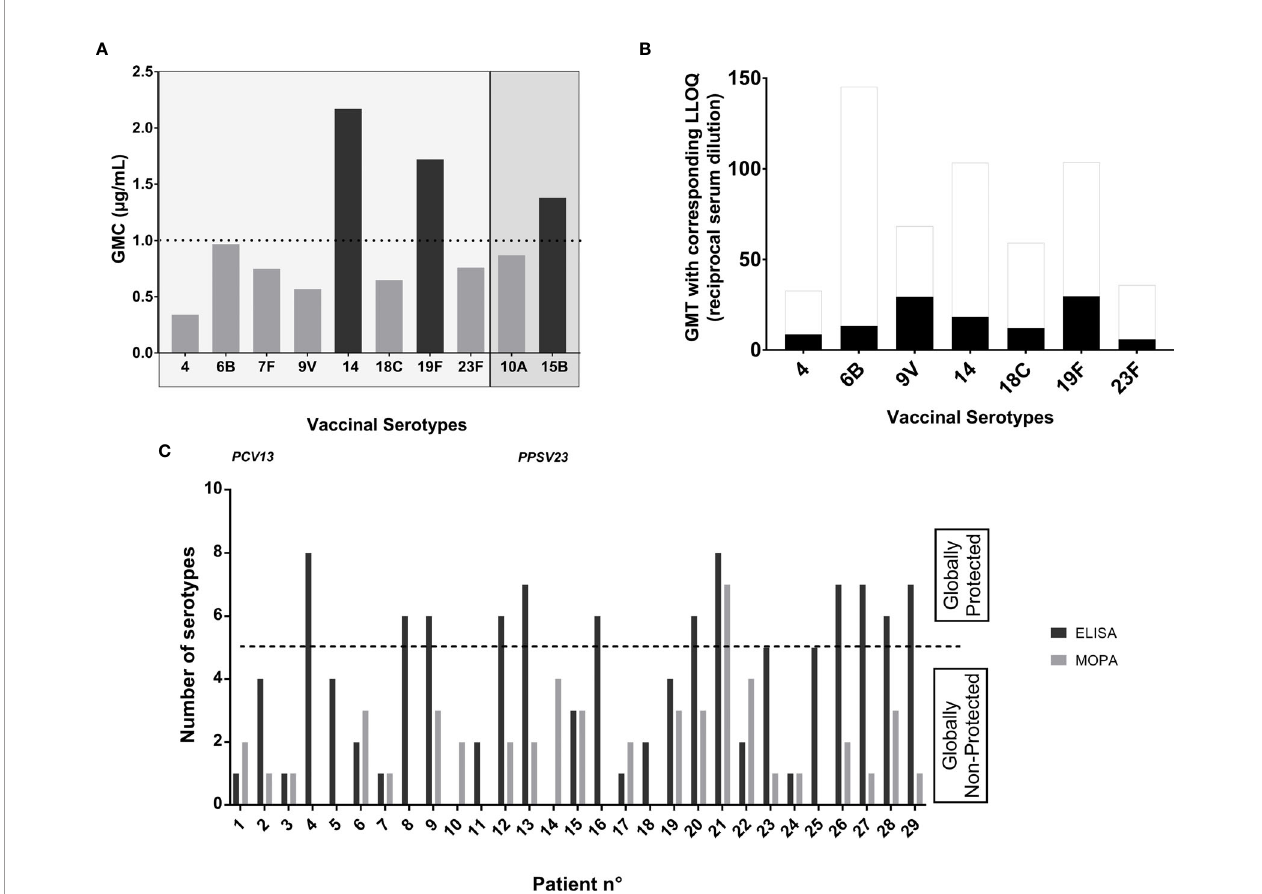
FIGURE 1 | Antibodies concentrations and opsonization titers toward pneumococcal serotypes before PCV13 vaccination. (A) Seric IgG concentrations at baseline: Data are in geometric mean concentrations (GMC) (µg/mL) calculated from seric IgG concentrations in ELISA for each tested serotype. Protection was de fi ned by an IgG concentration ≥ 1 m g/ml. The two serotypes 10A and 15B are not included in PCV13 vaccine and are represented here as controls. (B) Opsonization titers at baseline: Data are in geometric mean titers (GMT) (reciprocal serum dilution) calculated from opsonization titers (OT) in MOPA for each tested serotype. Protection was de fi ned as an OT ≥ LLOQ. LLOQ are represented as white columns above the GMT in black columns for each serotype. (C) “ Global protection ” at baseline: Number of pneumococcal serotypes for which an IgG concentration ≥ 1 m g/ml tested by ELISA and an OT ≥ LLOQ by MOPA was achieved, for each patient. Patients developing a protection for at least fi ve of the tested serotypes were considered as “ globally protected ” toward the serotypes included in the